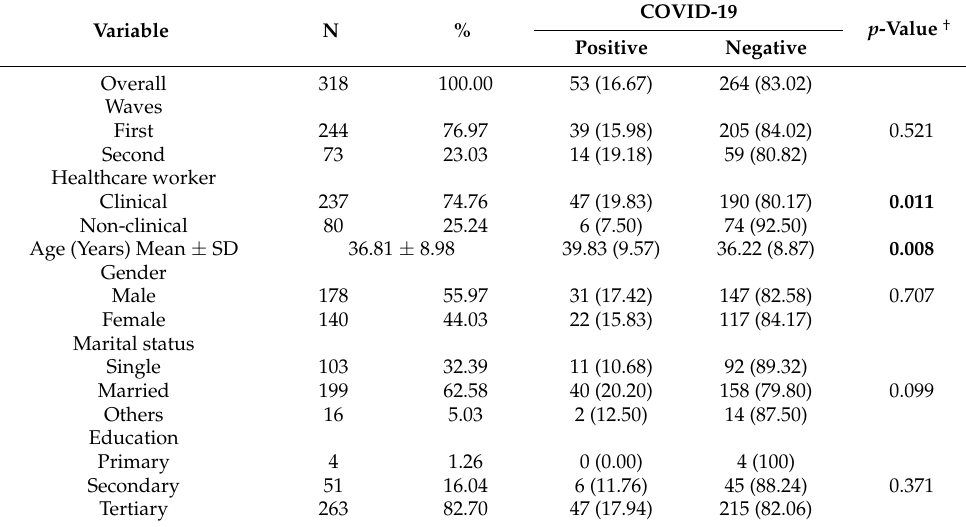
Table 1. Description of HCWs’ baseline characteristics and COVID-19 infection